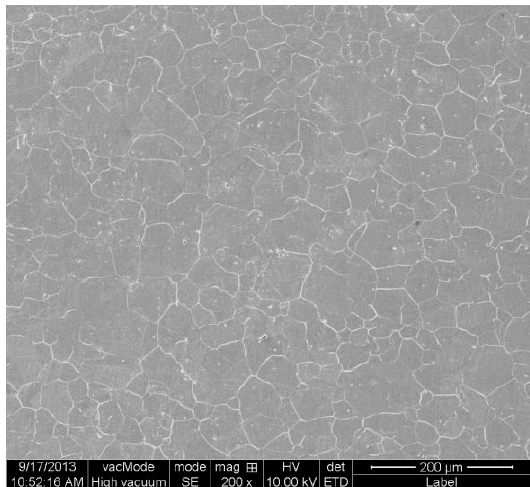
Figure 4. Microstructure of base